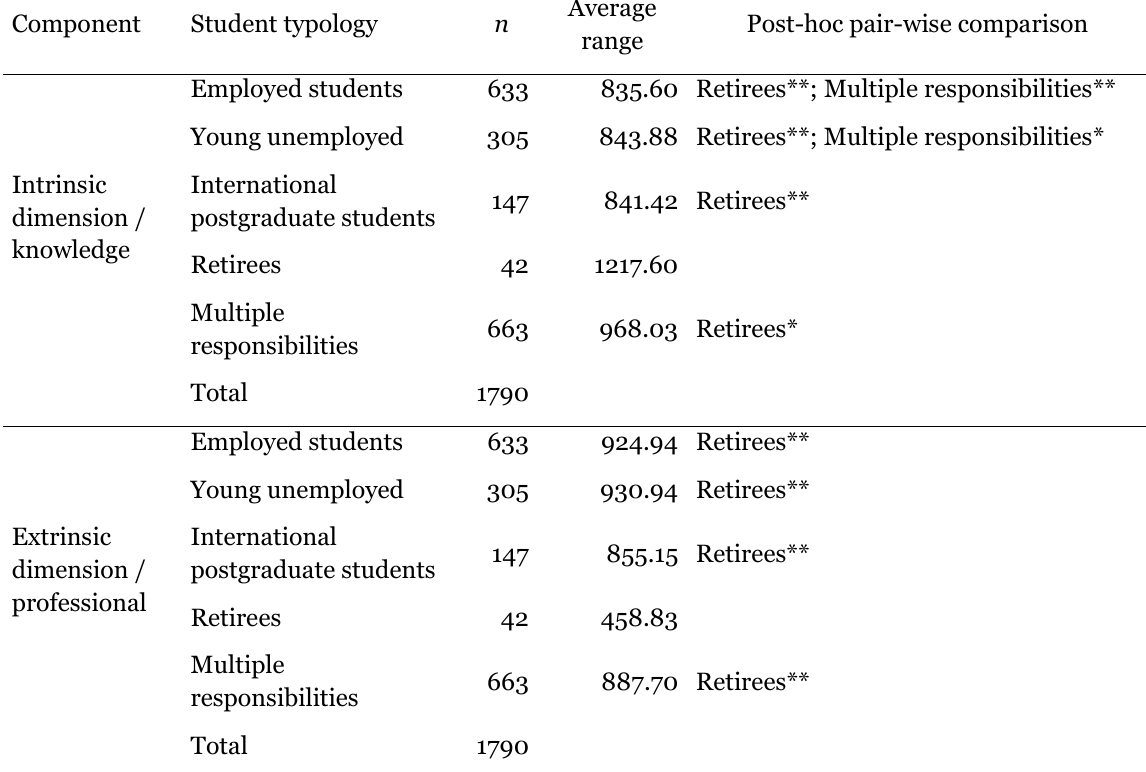
Results of the Kruskal-Wallis